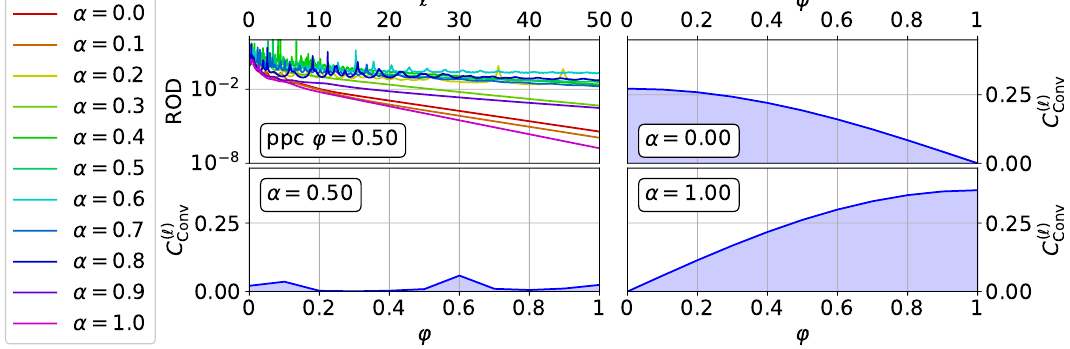
Figure 14: Top left: Exemplary ROD flow of the ppc-generator, see (75), with fixed ϕ = 0.5 for mixed random matrices with varying α . The other three panels show the convergence coefficients, each for a fixed random matrix with given α , diagonalized by the ppc-generator with various values of ϕ . All matrices are of dimension D =